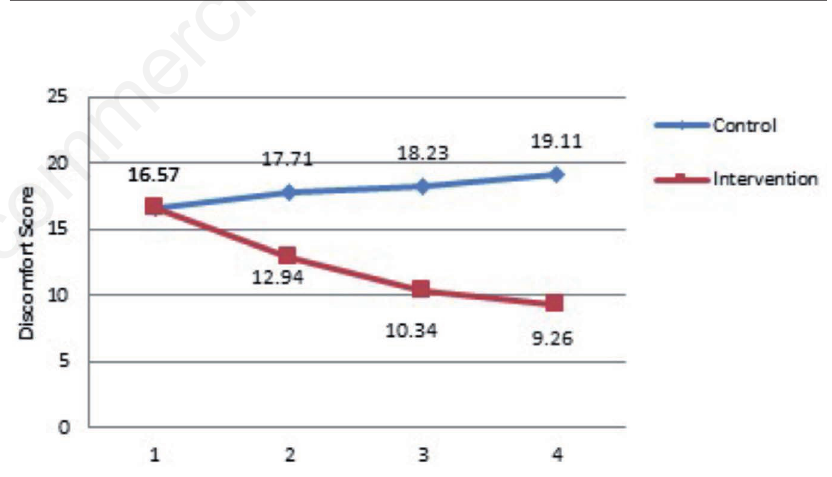
Figure 3. Comparison of the effect of breastfeeding pillow on reducing maternal discom- fort in the intervention and control